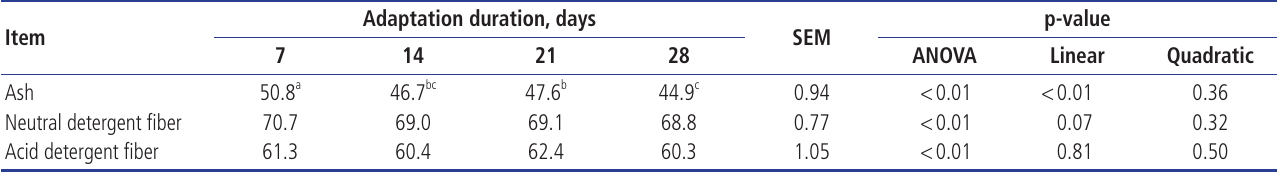
Table 5. Effects of adaptation duration on the apparent total tract digestibility (ATTD, %) of ash, neutral detergent fiber (NDF), and acid detergent fiber (ADF) in diet, regardless of the effect of inclusion level of palm kernel meal 1),